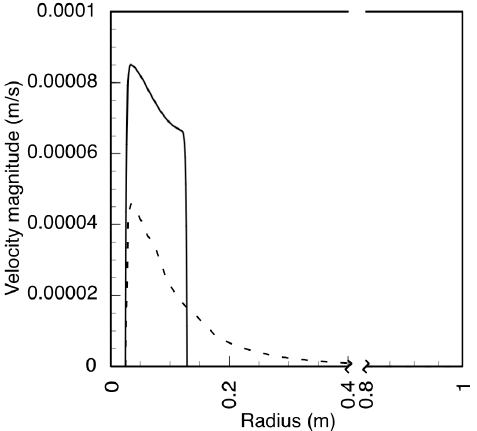
Figure 4. The velocity magnitude along the transect z = 0.207 m for the computational fluid dynamics (CFD) simulations: the simulated physical VCW tank with r = 0.129 m, (solid), and the large-domain VCW with r = 1.000 m (dashed).